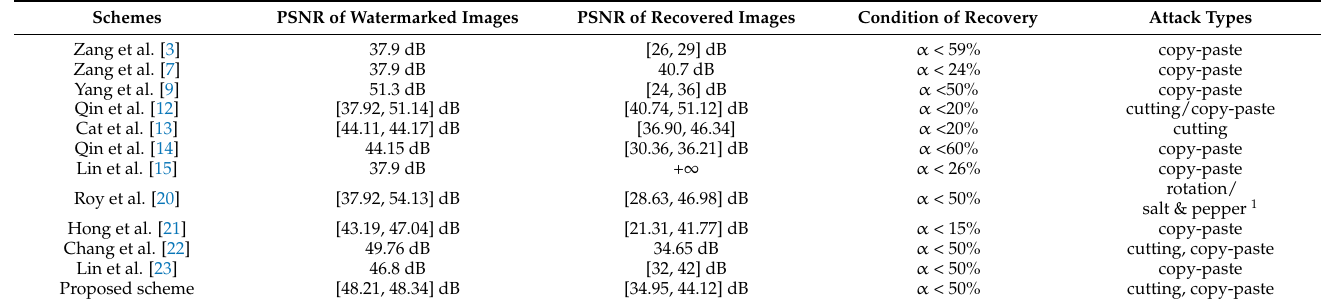
Table 8. Performance comparison of proposed scheme versus eleven schemes.